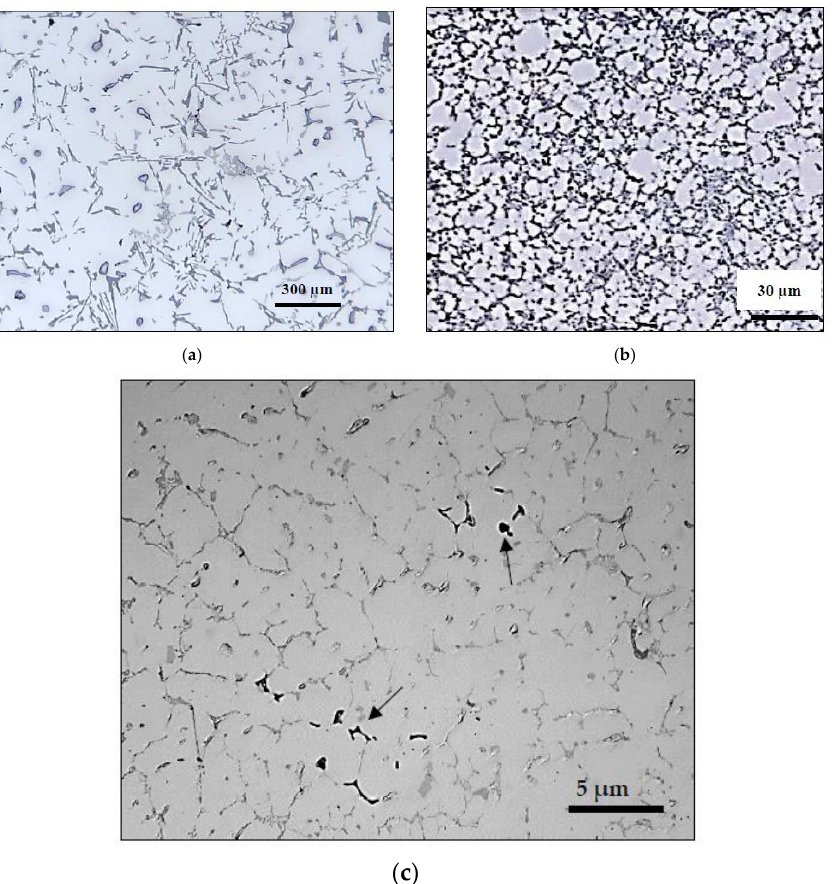
Figure 7. Optical microstructure obtained from samples taken from ( a ) thermal analysis casting, ( b ) die-cast alloy A, and ( c ) porosity observed in ( b )-black arrows.